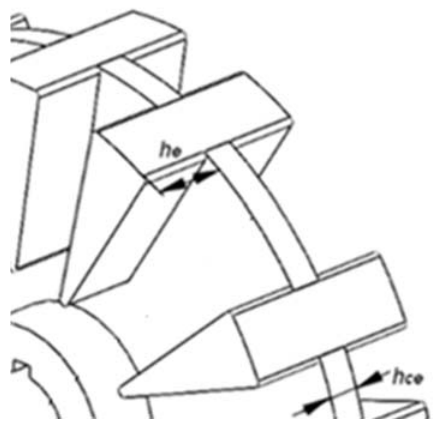
Figure 6. Arrangement of stator poles into the structural disk.